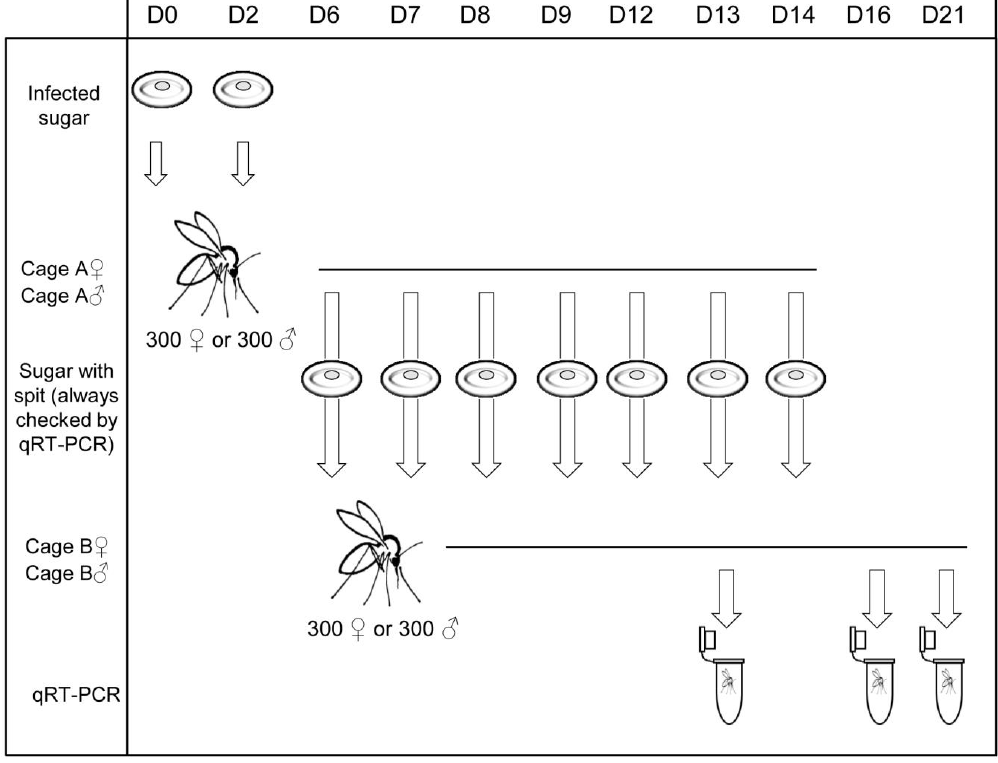
Figure 1. Schema of the co-feeding (CoF2) experiment.